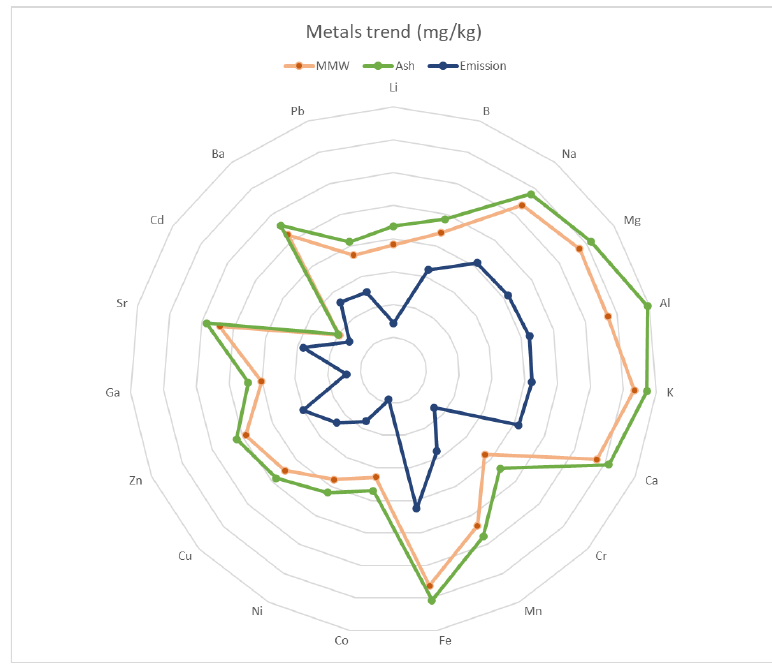
Figure 9. Metal trend in MMW, ash and emission.